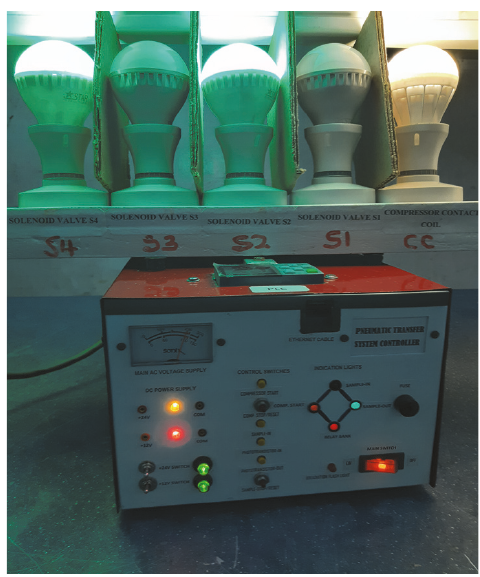
Figure 20: Irradiated sample transferred onto detection for counting. Solenoid valves S2 and S4 open.